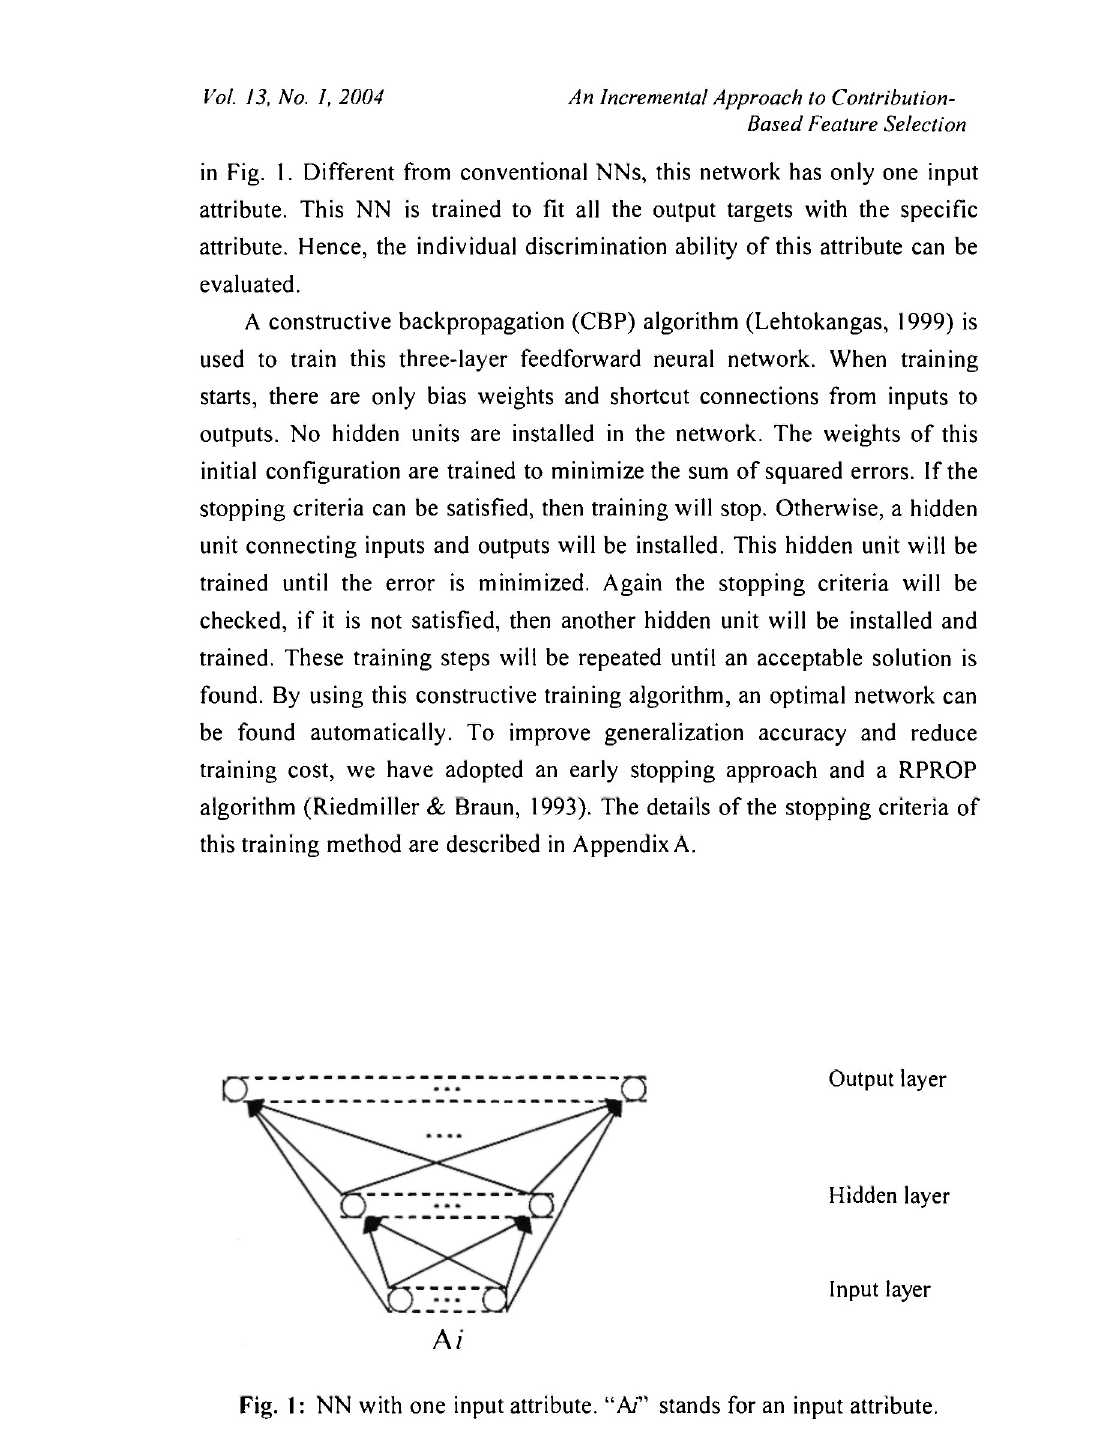
Fig. 1: NN with one input attribute. "Ai" stands for an input